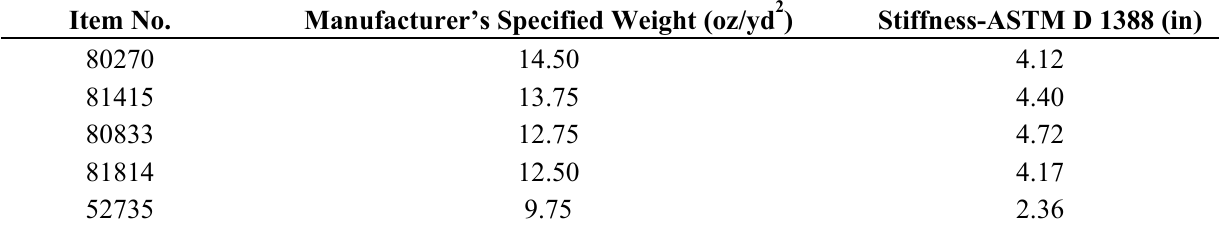
Table 1. Fabrics’ weight